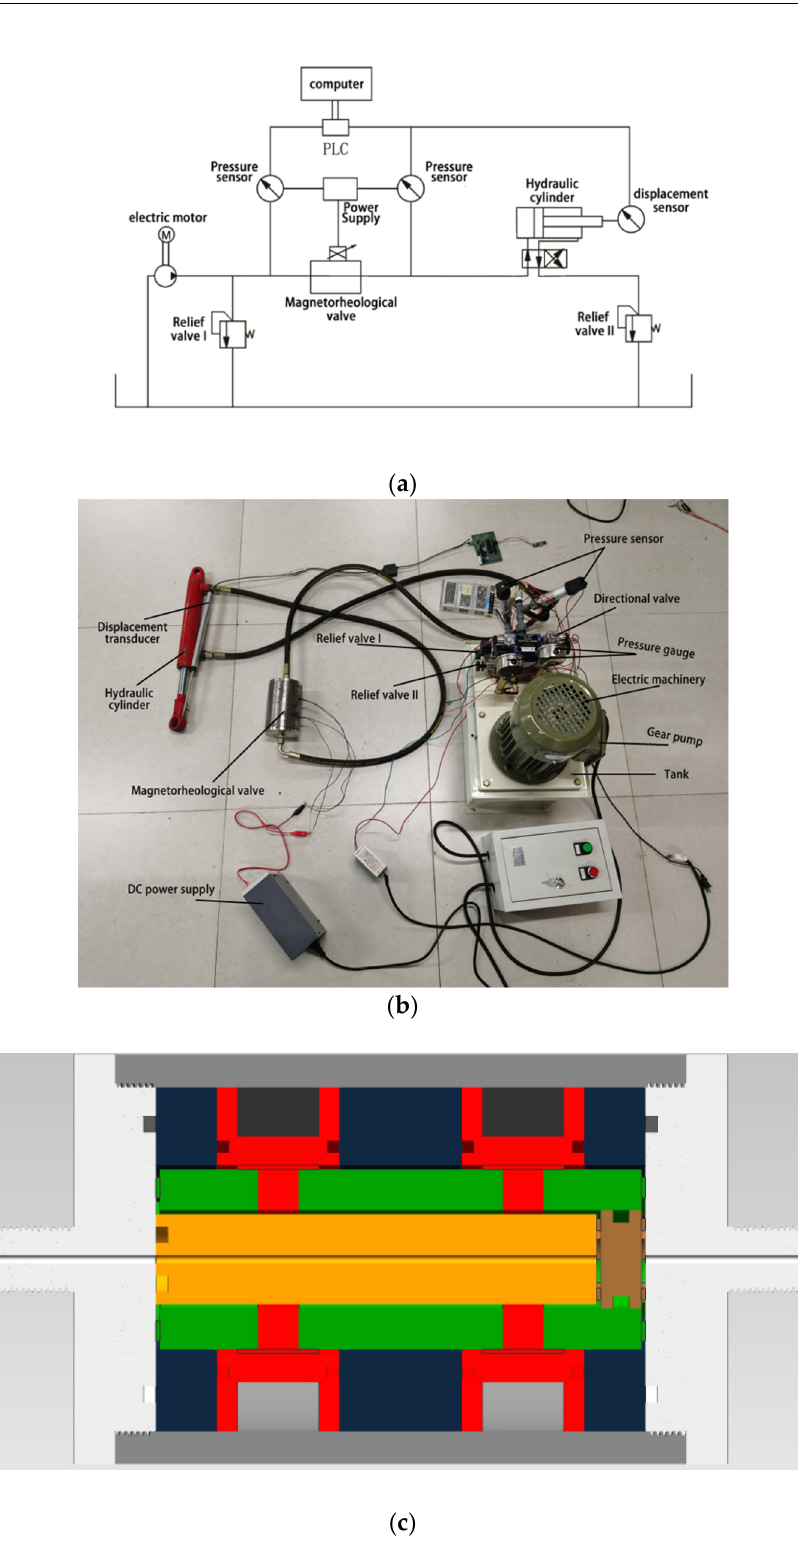
Figure 11. ( a ) Schematic diagram of the experimental system; ( b ) test rig picture; ( c ) three-dimensional assembly drawing of annular multi-channel MR